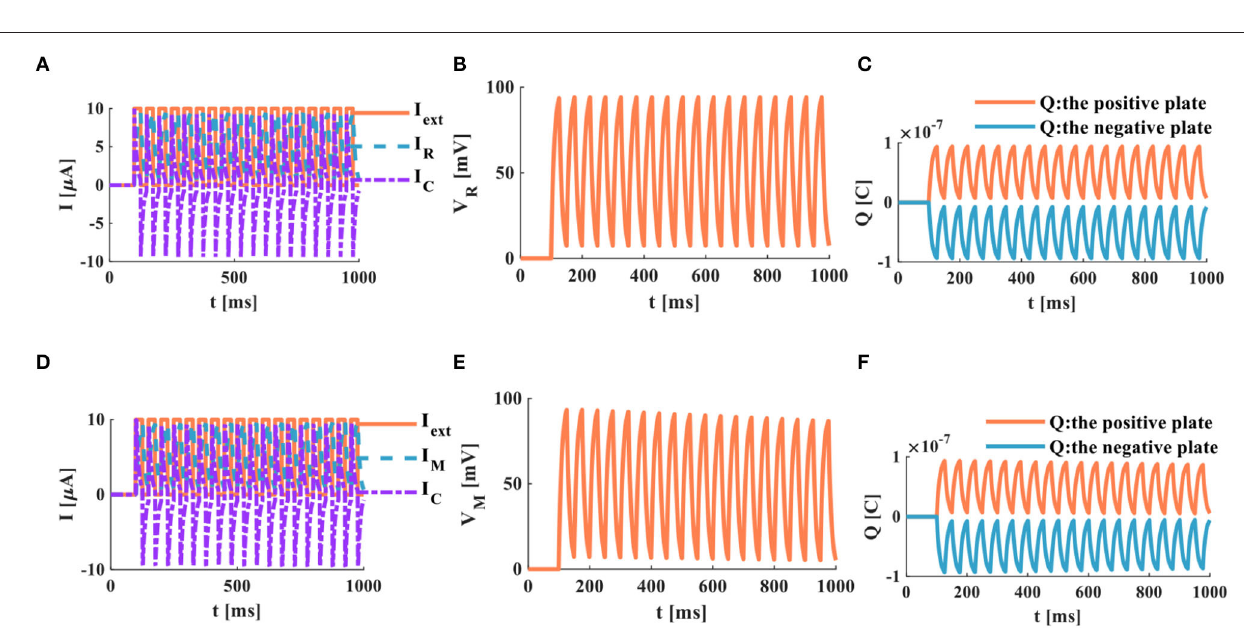
FIGURE 9 | A series of current pulses act on the RC and the MC neuron circuits (the number of external stimuli is 16), (A) the current flows through the resistor R and the capacitor C, (B) the membrane potential of the RC circuit, (C) the charges on the positive and negative plates in the RC circuit, (D) the current flows through the memristor M and the capacitor C, (E) the membrane potential of the MC circuit, (F) the charges on the positive and negative plates in the MC